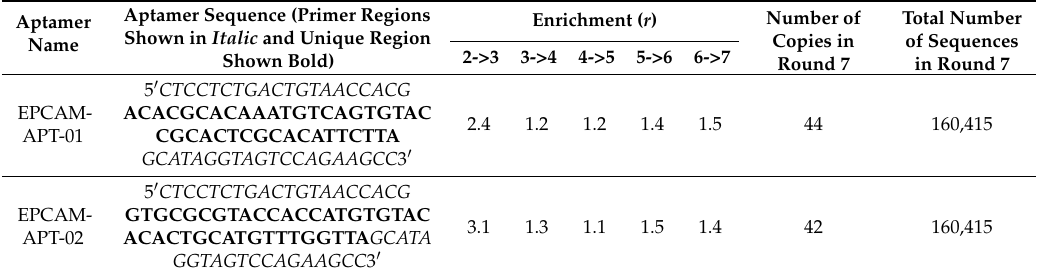
Table 3. DNA sequences of anti-EpCAM aptamers.